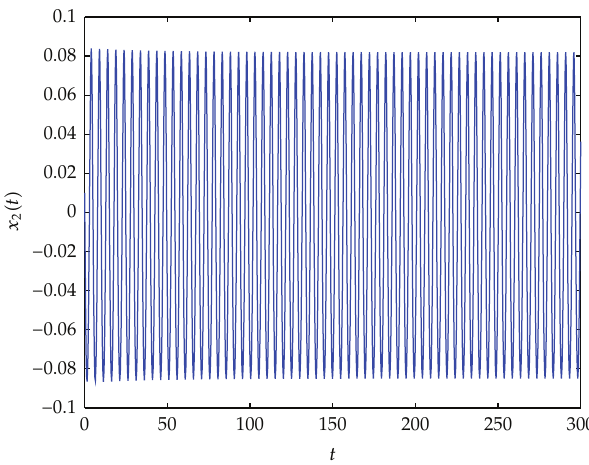
Figure 5: Trajectories graphs of the system (cid:2) 4.1 (cid:3) with τ 1 (cid:6) 0 . 01 ,τ 2 (cid:6) 0 . 04, and τ 1 (cid:7) τ 2 (cid:6) 0 . 05 > τ 0 ≈ 0 . 01. Hopf bifurcation occurs from the equilibrium E ∗ (cid:2) 0 , 0 (cid:3) . The initial value is (cid:2) 0.05, 0.01 (cid:3) .